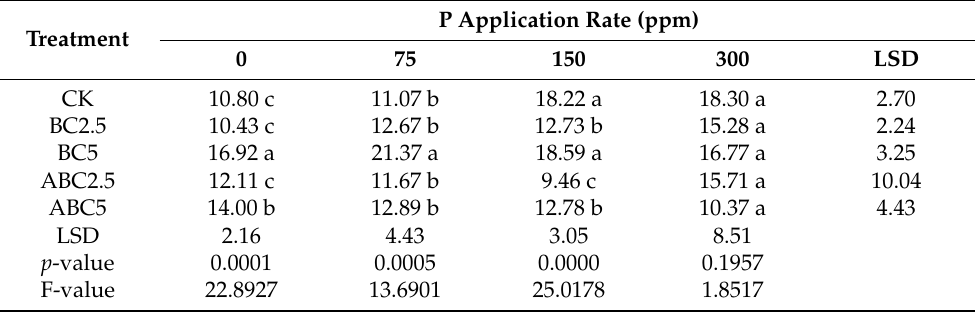
Table 9. Effects of BC and ABC applied at different rates with different P fertilizer application rates on Plant K concentration